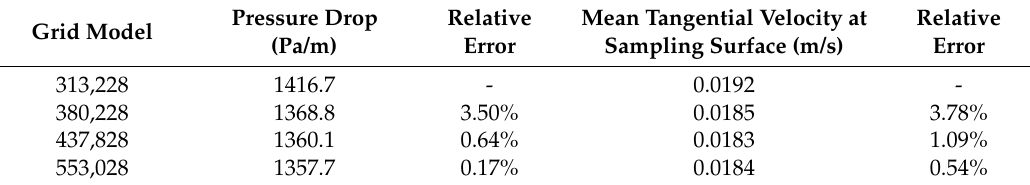
Table 2. Grid independence tests.